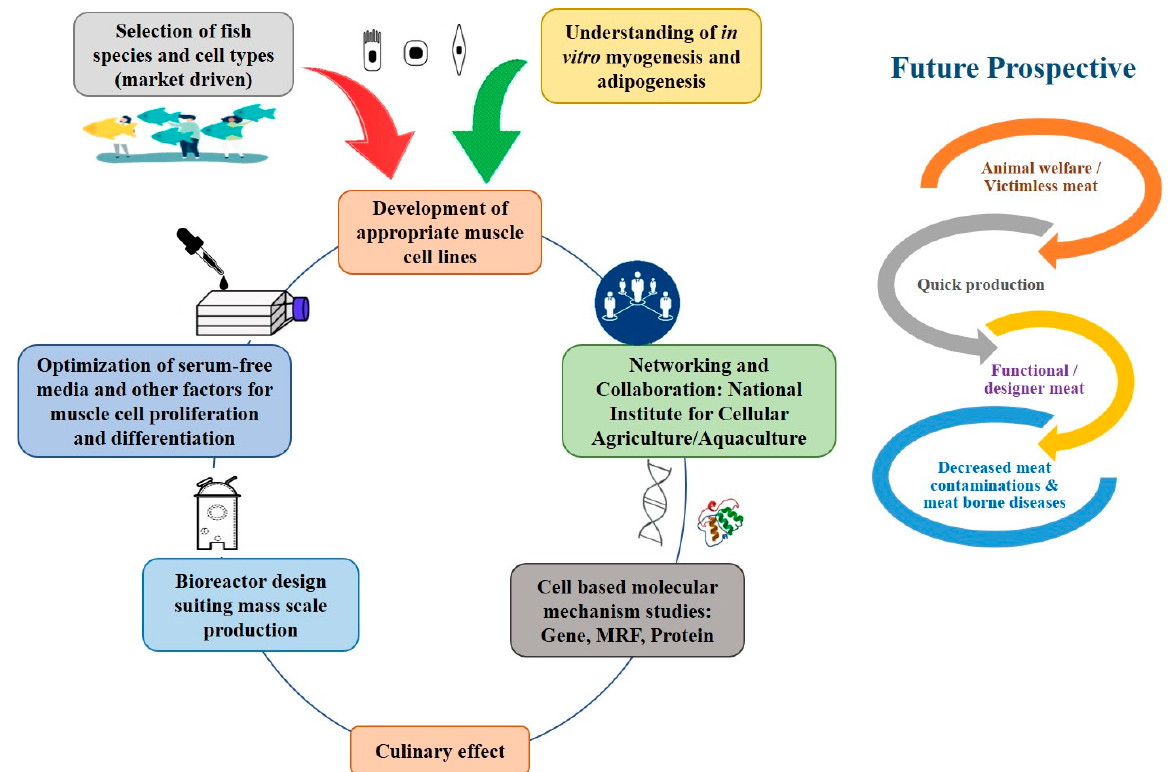
Figure 2. Networking and future prospective of cellular aquaculture.